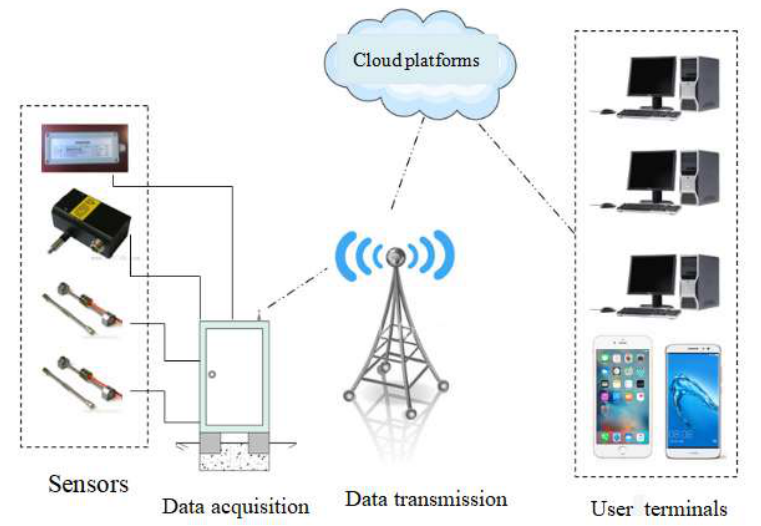
Figure 1. Monitoring system composition.